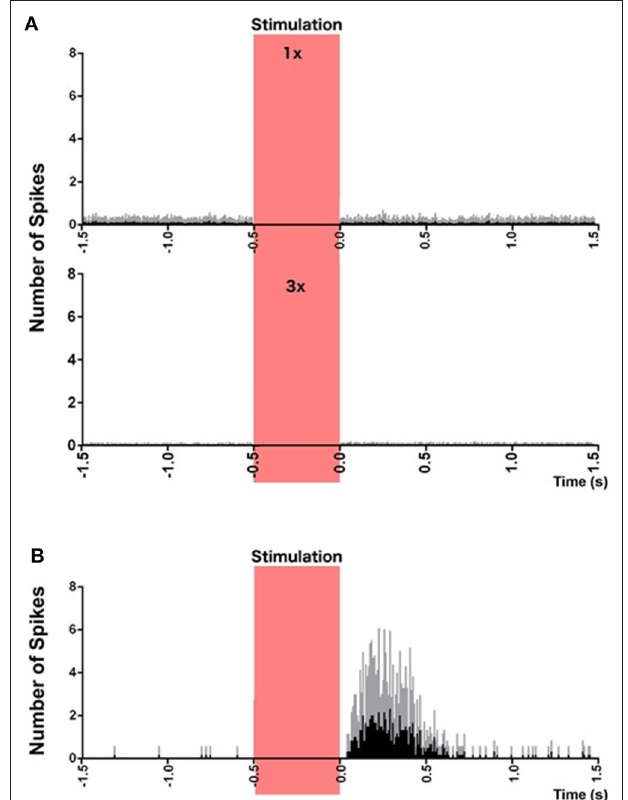
FIGURE 4 | Peri-stimulus histograms of neuronal responses to electrical vestibular stimulation. (A) Combined histogram of firing of all non-responsive neurons at 1 × (top) and 2 × (bottom) the threshold of nystagmus. (B) Combined firing of all 6 responsive neurons, at 3 × the threshold of nystagmus, phase-locked to the stimulus. Red bar represents the stimulation period. Spikes from the stimulus artifact have been removed for clarity. Data are presented as mean (black bars) and standard deviation (gray bars). From Stiles et al. ( 59) with